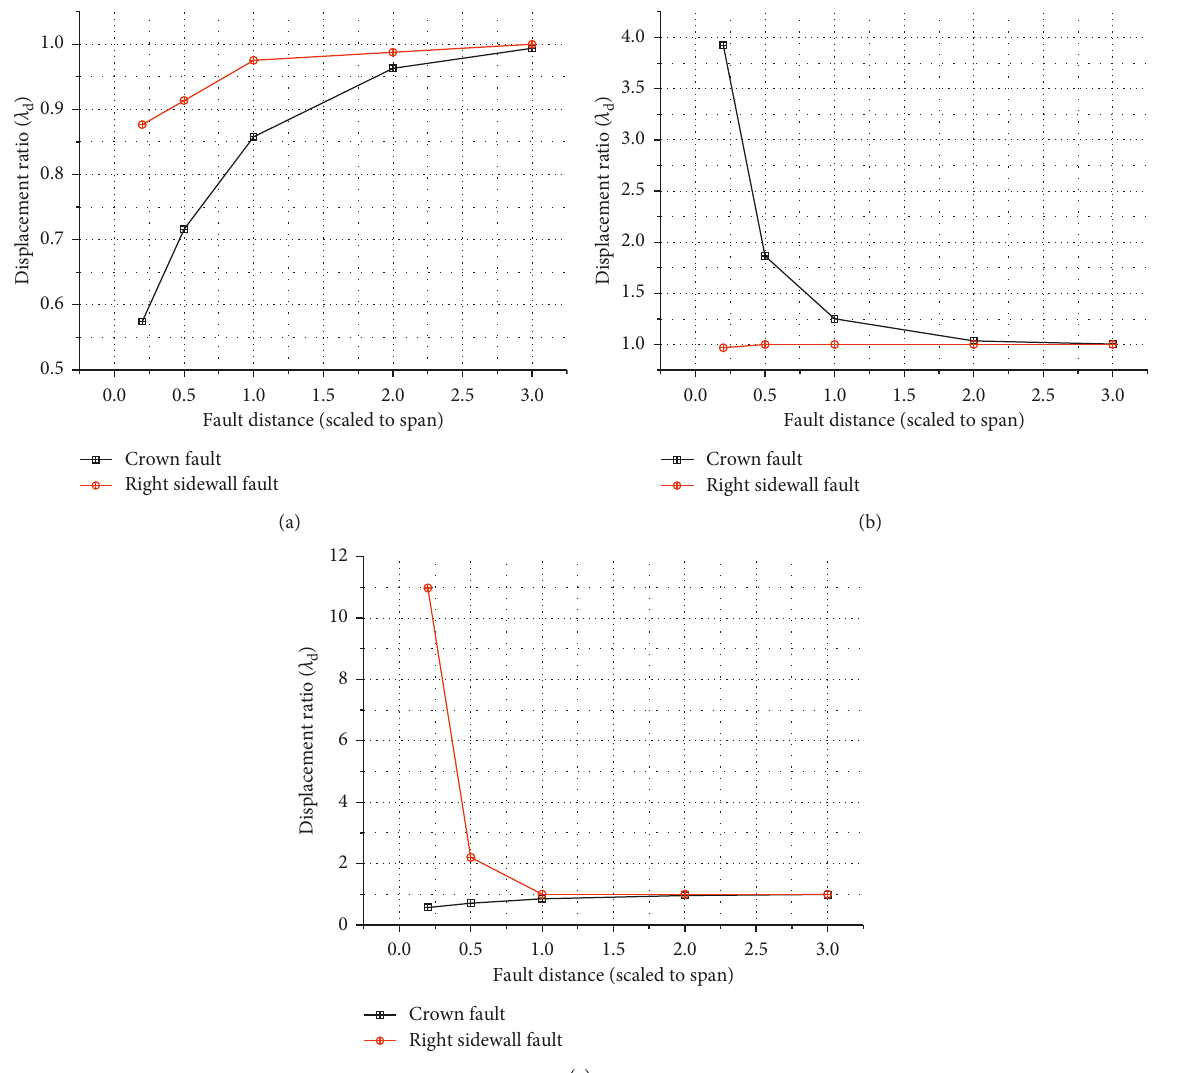
Figure 6: The displacement ratio vs. fault distance: (a) middle point of left sidewall; (b) top of crown; (c) middle point of right sidewall.